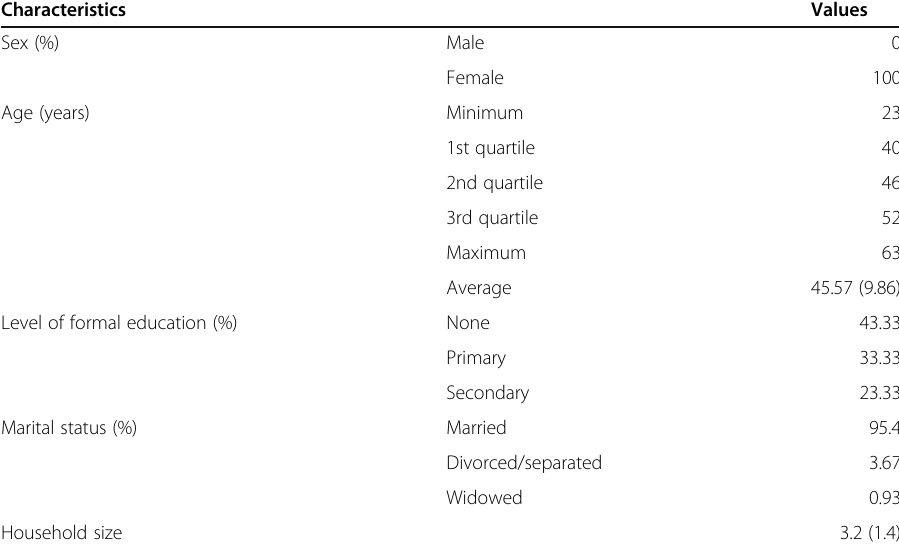
Table 3 Socio-demographic characteristics of the woman artisans surveyed Characteristics Values Sex (%)